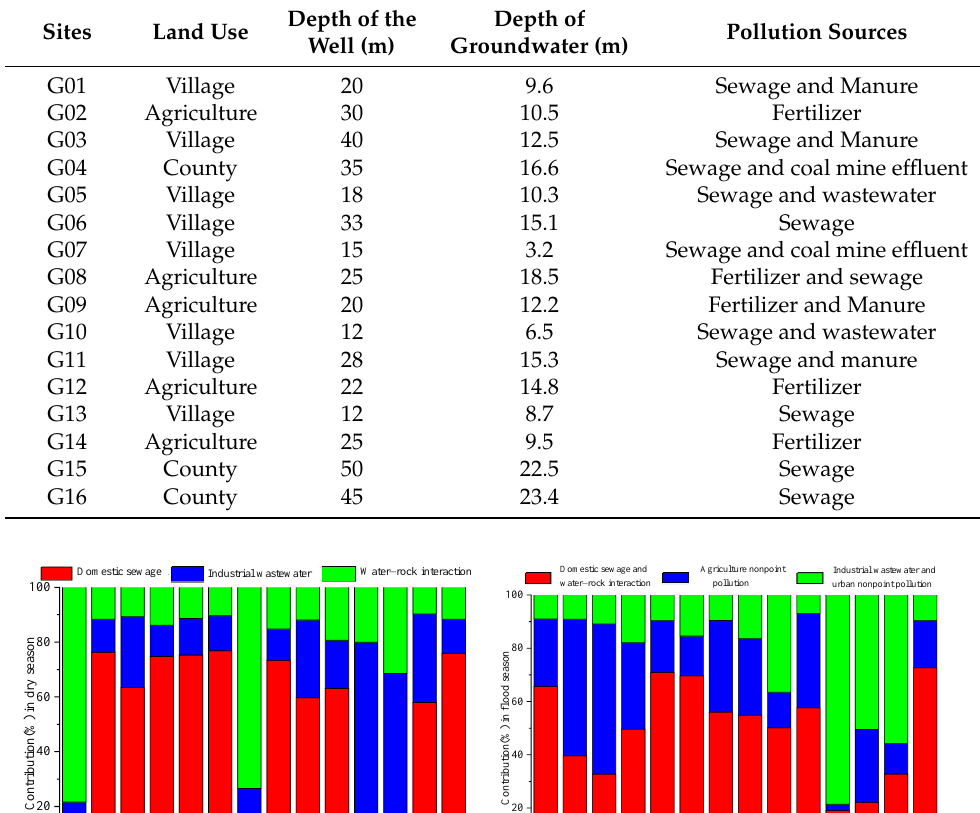
Table 5. Statistic table of the main characteristics of each site.